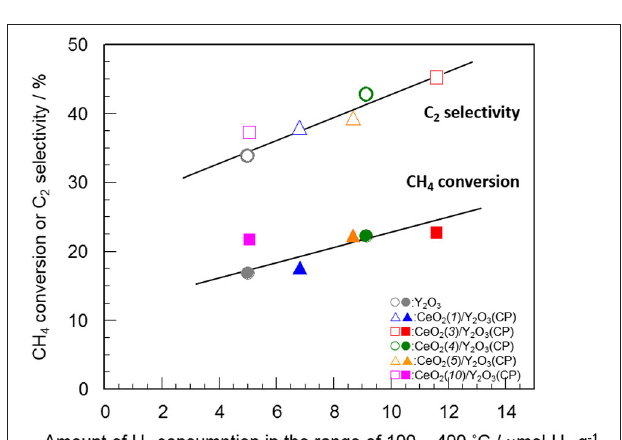
FIGURE 8 | Relationship between the amount of H 2 consumption for the reduction of surface/subsurface oxygen species and the catalytic activity for the OCM reaction at 750 ◦